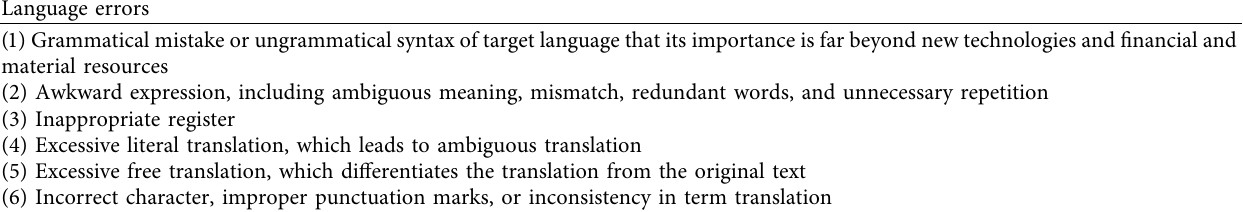
Table 1: Classification of linguistic error types adopted from Liao